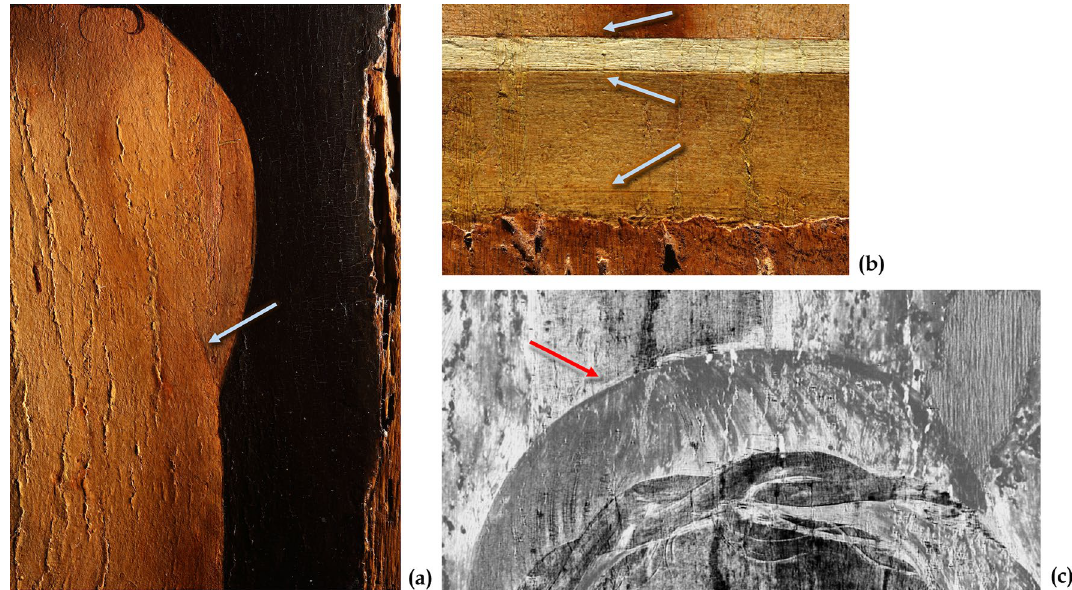
Figure 6. The use of faint incision as a reference for the torso and the parapet and imaging of a pentimento . ( a ) Details in visible light of the slight incisions made to delineate the torso, ( b ) the parapet and as a reference for positioning the frame (photos by Carlo Pagani). ( c ) Detail of the upper part of the painting in the infrared region where a pentimento is visible, with a change in the position of Christ’s head.